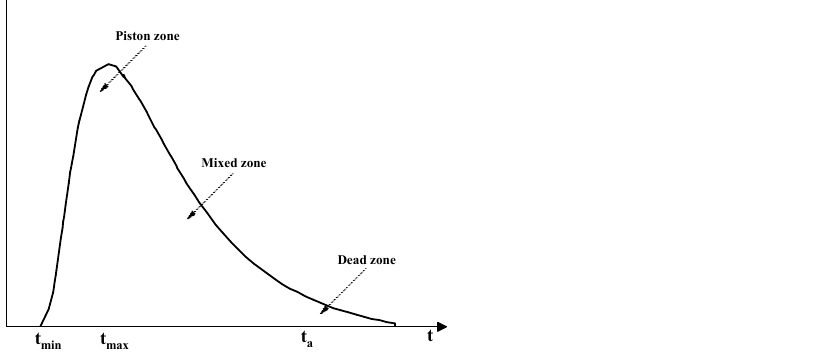
Figure 4. Theoretical average residence time distribution function.